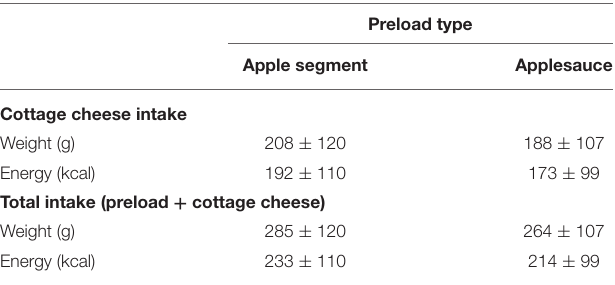
TABLE 5 | Weight and energy intake of cottage cheese after each preload (mean ±